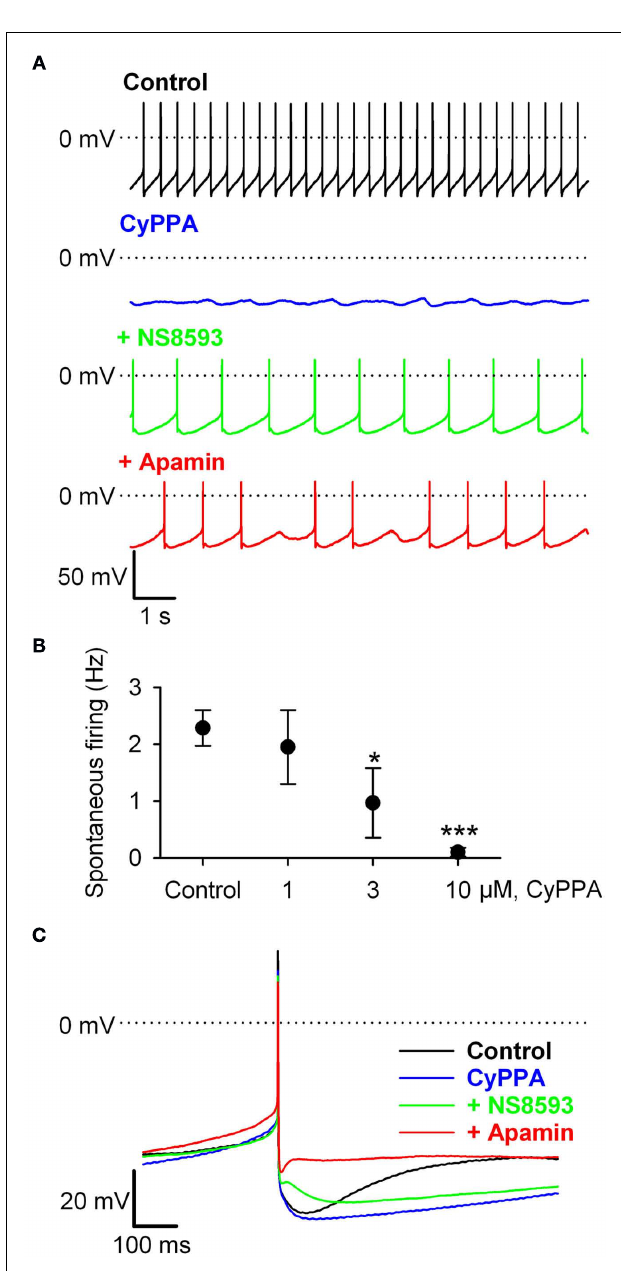
FIGURE 1 | CyPPA inhibits spontaneous activity via. prolongation of the apamin-sensitive medium afterhyperpolarization (mAHP) in SNc DA neurons in mice midbrain slices. (A) Typical pacemaker-like activity (black trace), is inhibited by superfusion with 10 μ M CyPPA (blue trace), which increases mAHPs and eventually silences firing activity. Co-administration with 10 μ M NS8593 resumes pacemaker firing (green trace), whereas apamin (300nM) caused a slightly further increase in firing frequency and more irregular firing. (B) Concentration-response curve of spontaneous firing activity before and after CyPPA superfusion (control, 1, 3, 10 μ M, n = 7, 2, 3, and 5 respectively. One-way ANOVA followed by Holm Sidak multiple comparison test. * P < 0.05 and *** P < 0.001). (C) Overlain single spikes before and after CyPPA (10 μ M), CyPPA + NS8593 (10 μ M), and CyPPA + NS8593 + apamin (300nM). Color coding as in (A) . Note the prolongation of the mAHP by CyPPA, which is reduced by NS8593, and completely blocked by